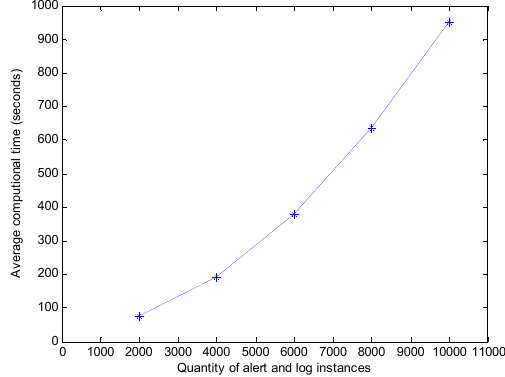
Figure 13. Computational time varies with the instance quantity changes.